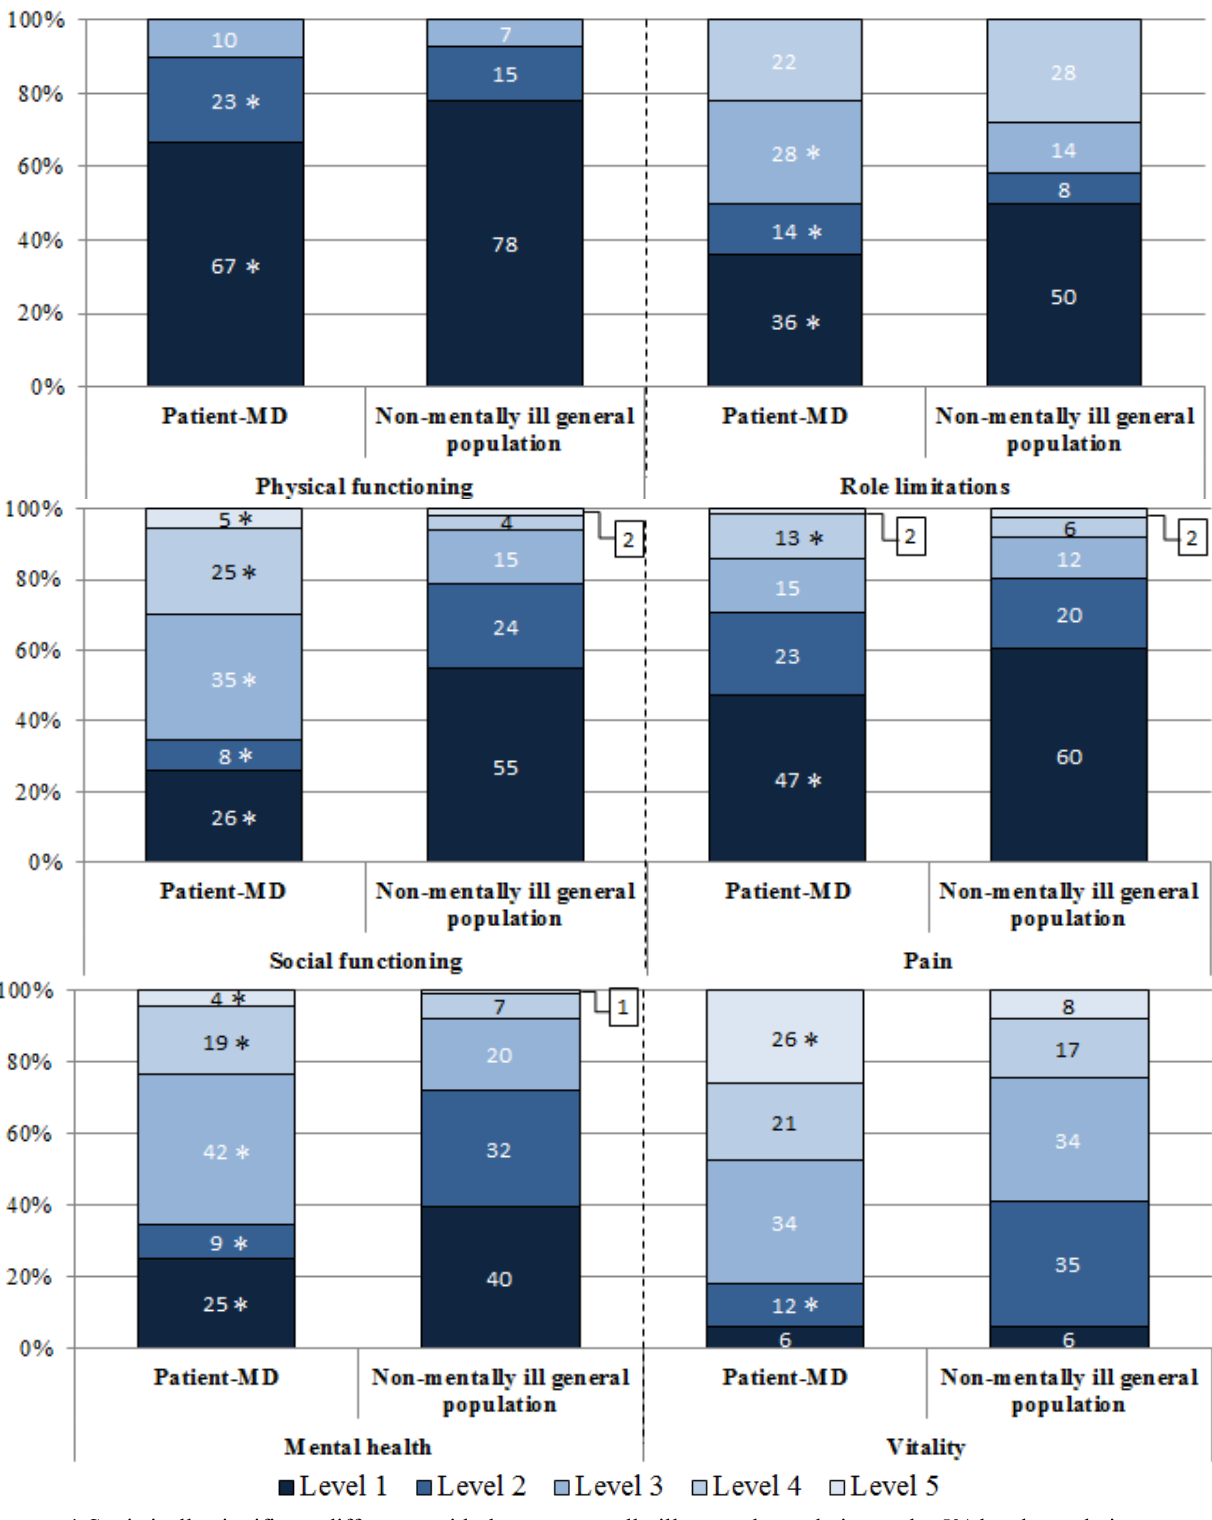
Figure 1. Differences in the distribution for the SF-6D (SF-12) dimensions between the Patient-MD group ( N = 203) and the non-mentally ill general